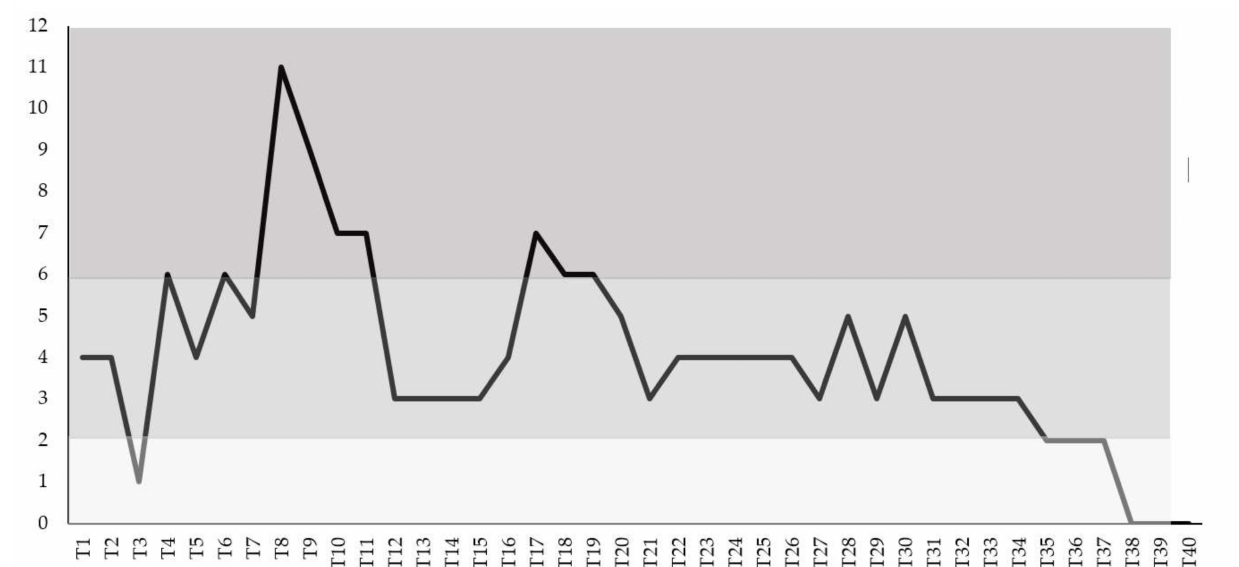
Figure 3. Clinical score in the BCoV naturally infected calf calculated based on daily registrations of clinical signs. A score above or equal to six on three consecutive days was observed from T8 to T11 and from T17 to T19 (moderate disease), while a score of eleven was revealed only at T8.